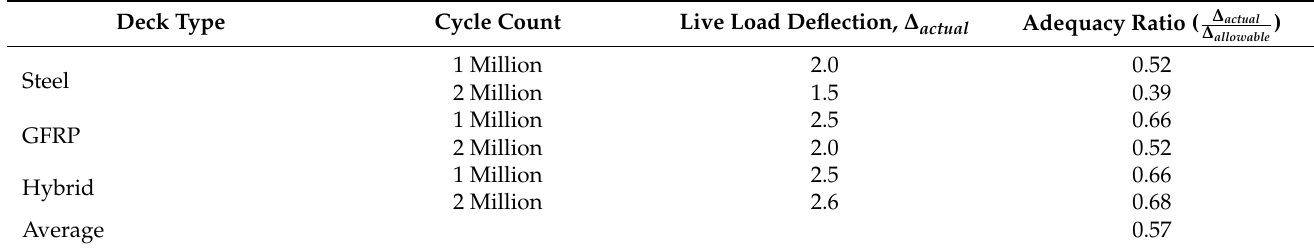
Table 7. Adequacy of bridge decks for live load deflection.